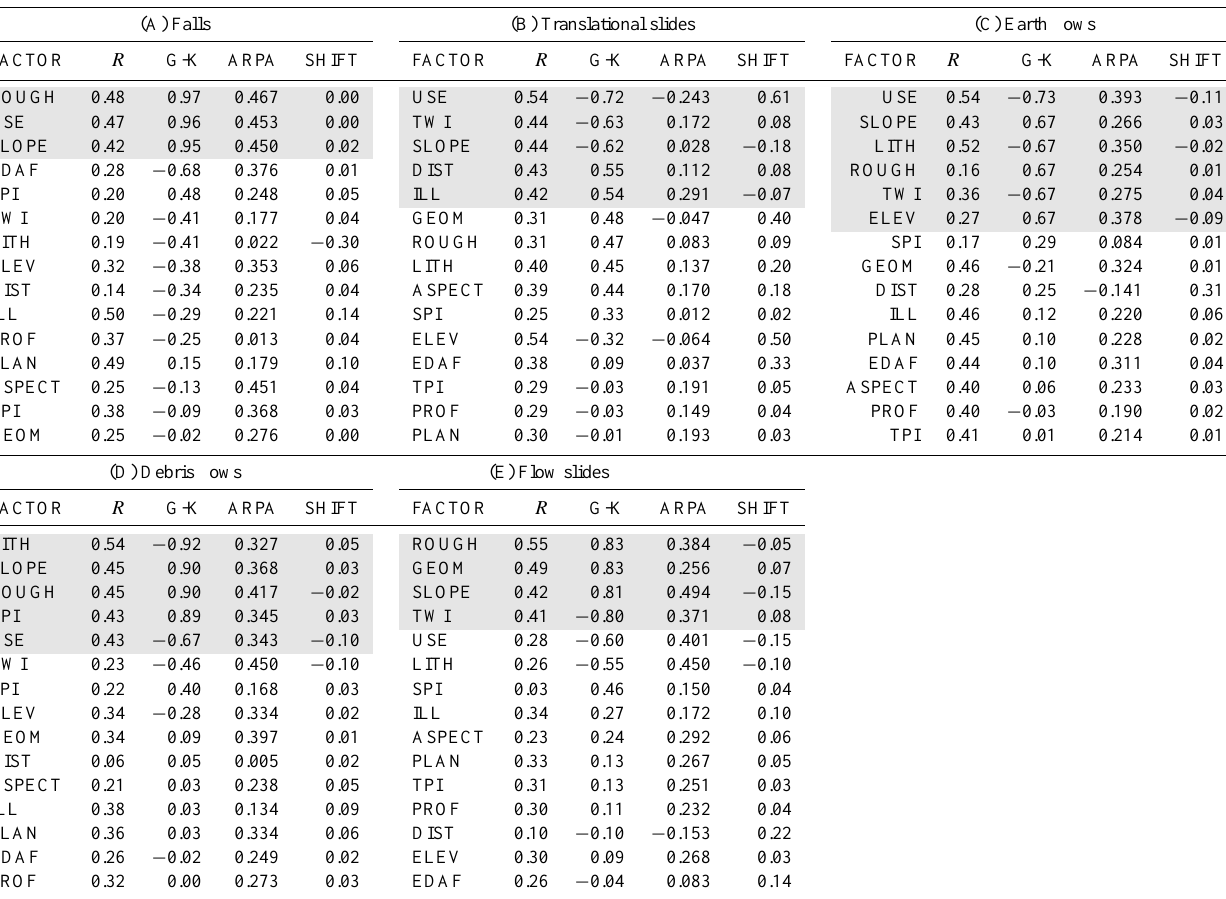
(A) Falls (B) Translational slides (C) Earth